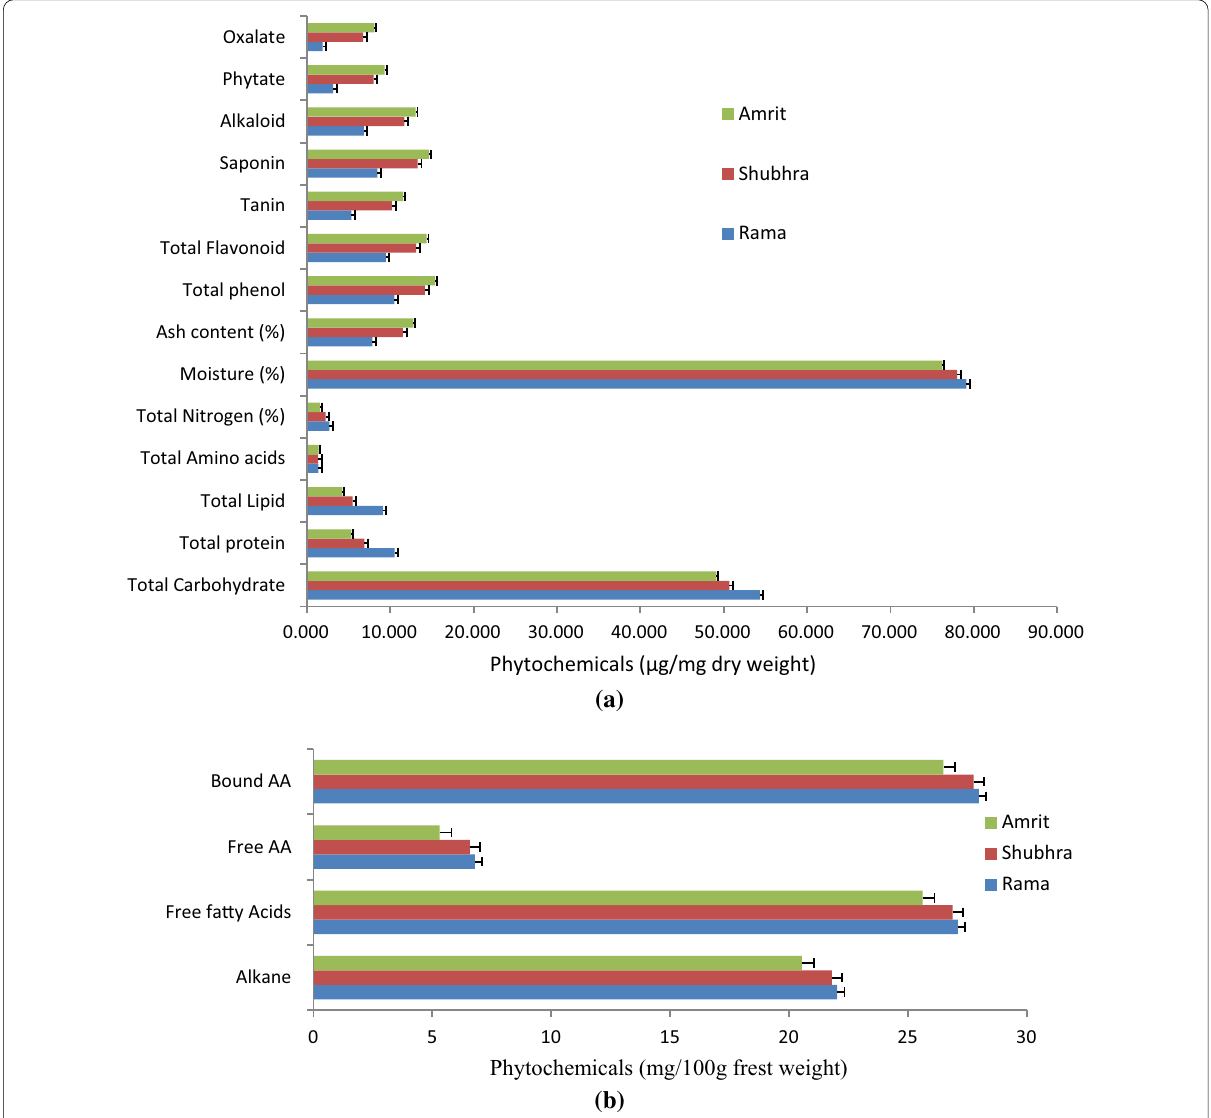
Fig. 1 Phytochemical variations (Mean SE of 3 observations /cultivar) in a (μg/mg dry weight) and b (mg/100g fresh weight) of the selected ± sesame ( S. indicum ) cultivars (Rama, Shubhra and Amrit) cultivated during summer season in 2019. All the estimated chemicals significantly differed at P < 0.005 by Tukey’s (HSD)